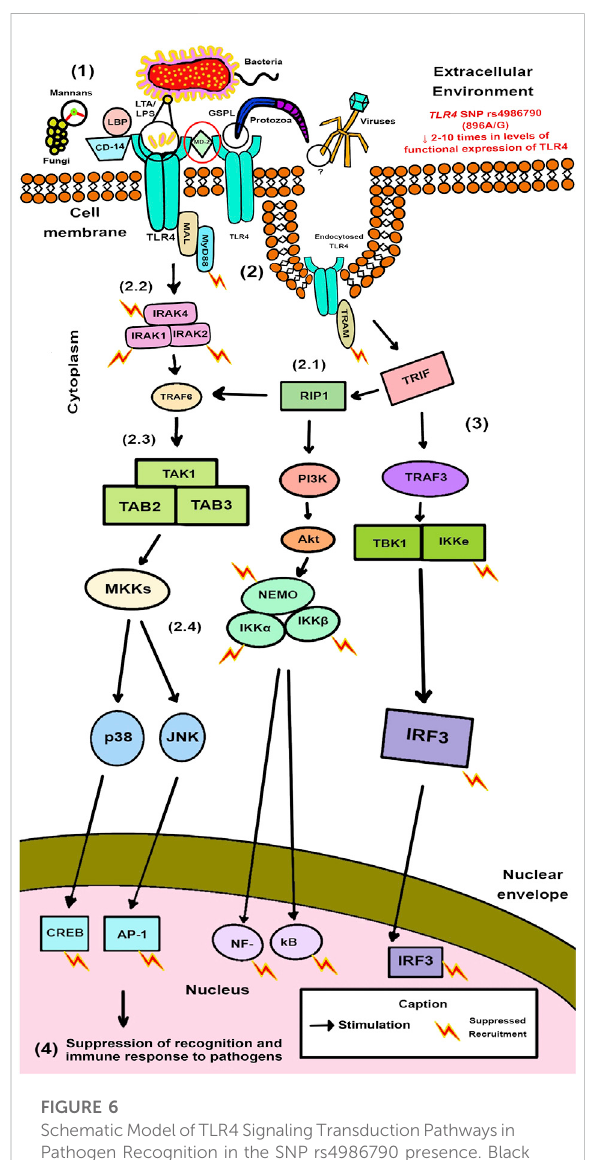
FIGURE 6 SchematicModelofTLR4SignalingTransductionPathwaysin Pathogen Recognition in the SNP rs4986790 presence. Black circles from the top section of the fi gure indicate the PAMPs that arerecognizedbyTLR4foreachtypeofinfectiousagent.The red circle highlights the increase in receptor dysfunction in its immune functions in the absence of MD-2. The red lightning symbols indicate the structural components of the TLR4 signaling pathway in which the mutation was associated with increased infection sensitivity identi fi ed in